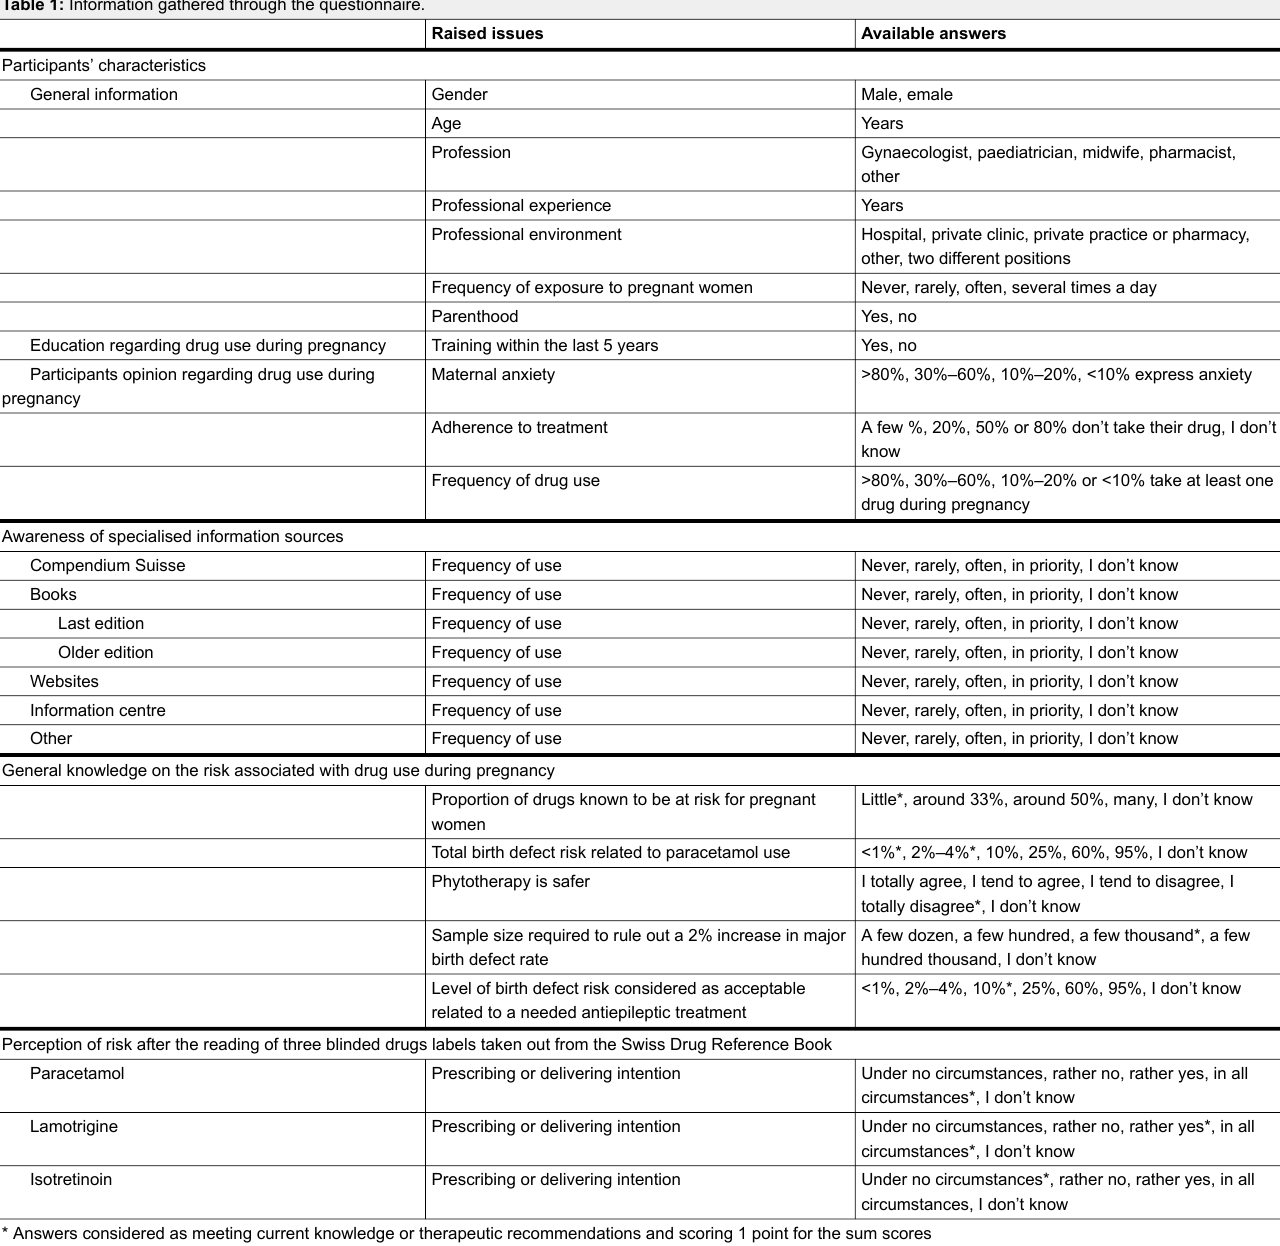
Table 1: Information gathered through the questionnaire.